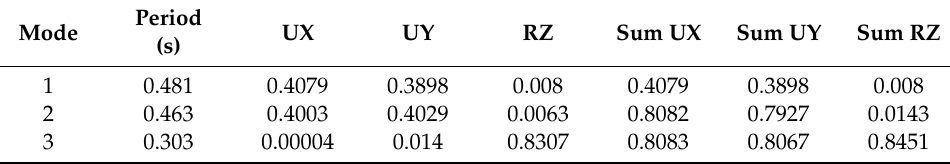
Figure 8. The 1st mode shape for T 1 = 0.481 s: ( a ) plane view, and ( b ) 3D view. Table 6. Ratios of the modal participating mass before the reducing of the